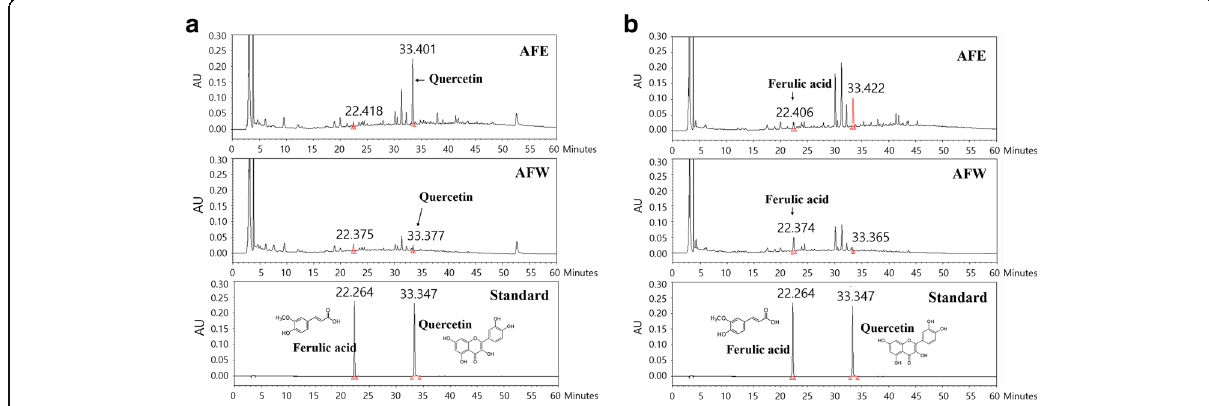
Fig. 1 High-performance liquid chromatography/photodiode array detector chromatograms of Allium fistulosum aqueous extract (AFW), A. fistulosum ethanolic extract (AFE), and standards for quercetin and ferulic acid. Quercetin and ferulic acid were detected at ( a ) 254 nm and ( b ) 300 nm,